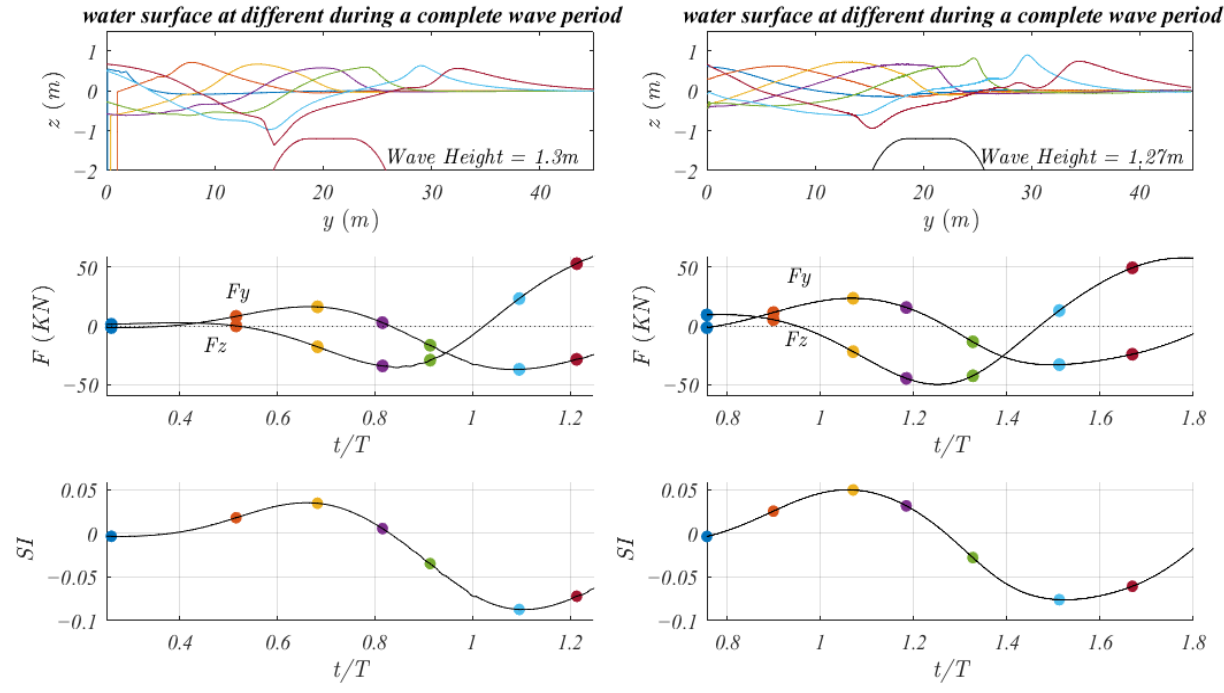
Figure 7. Water surface elevations, loads and SI for wave height 1.3 m and 1.27 m , T = 7 s , as obtained by BELWF (left) and by OpenFOAM (right), respectively.